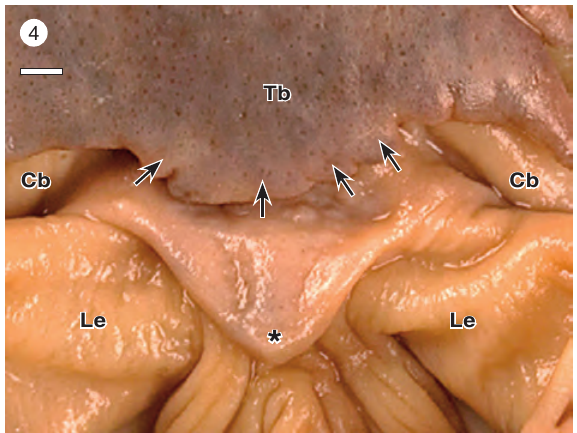
FIG. 4 Dorsal view of the triangular tongue root, showing the caudal extremity of the tongue root (*) folding over the laryngeal entrance (Le). In this specimen, the caudal lin­ gual papillae (arrows) of the tongue body (Tb) appear fused with variable incisures and small projections being apparent. The rostral parts of the paired ceratobranchi­ ale (Cb) are seen bordering the tongue root. Note the pitted surface of the tongue body, representing the open­ ings of the large underlying glands. Bar = 1 mm